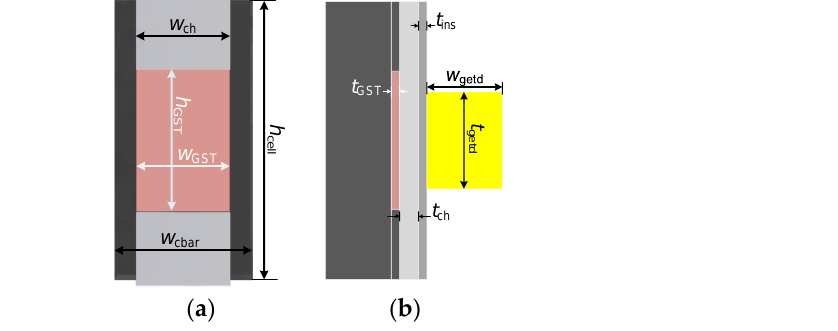
Figure 2. Schematics of the proposed vertical PCM arrays with a ( a ) diploid unit and ( b ) four-fold unit.